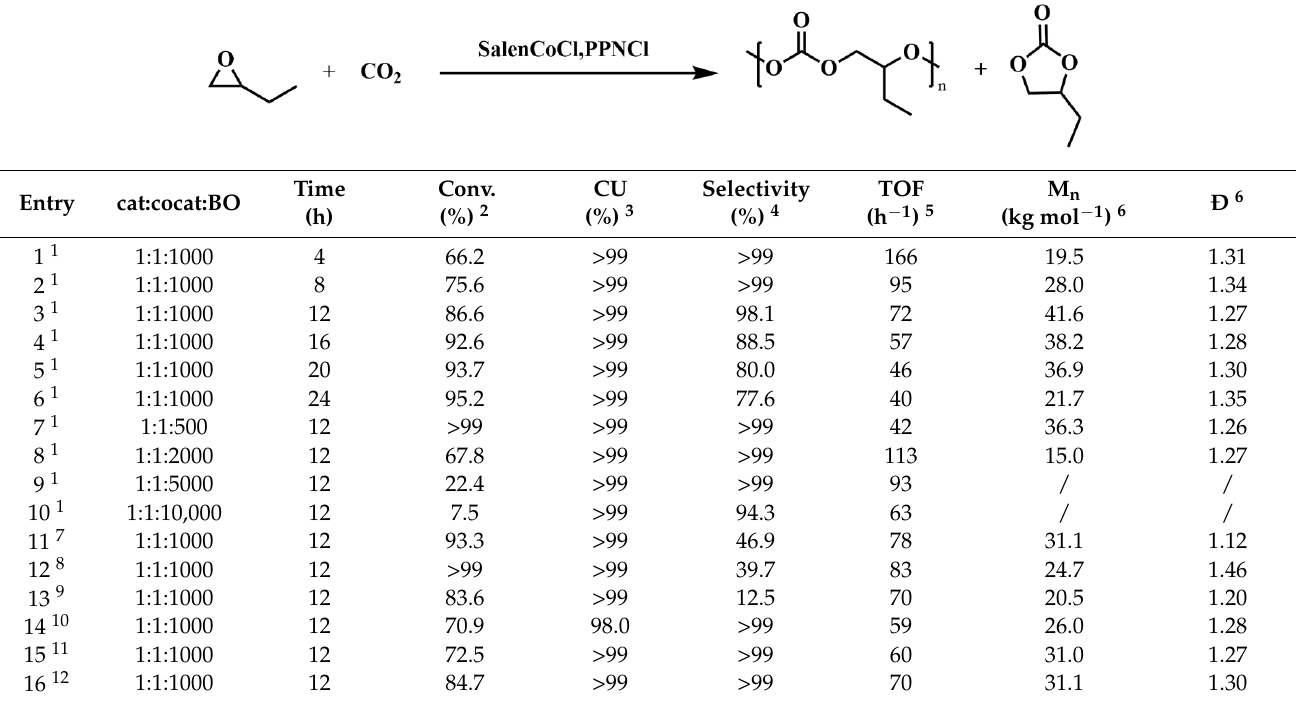
Table 1. Copolymerization of CO 2 and BO.